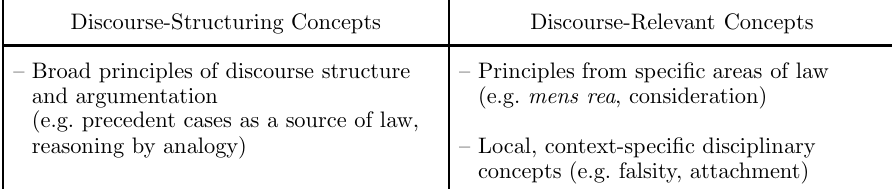
Discourse-structuring and discourse-relevant legal concepts Discourse-Structuring Concepts Discourse-Relevant